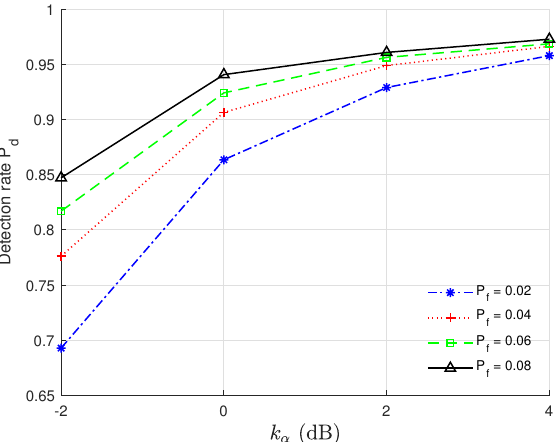
Figure 5. P d vs. k α with the settings of (SNR = 10 dB, N r = 128, L = 25, k φ = 2 dB, k θ = 2